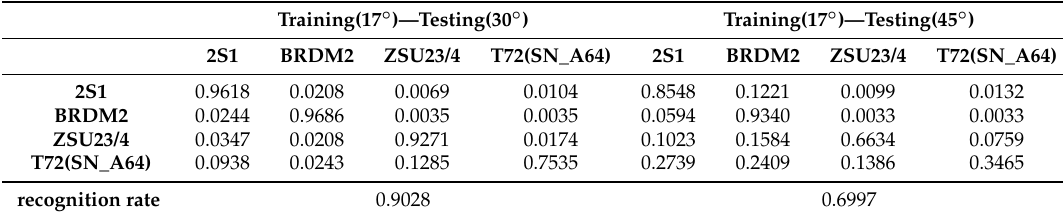
Table 10. The result of SDDLSR based on the wavelet decomposition image under EOC_d.